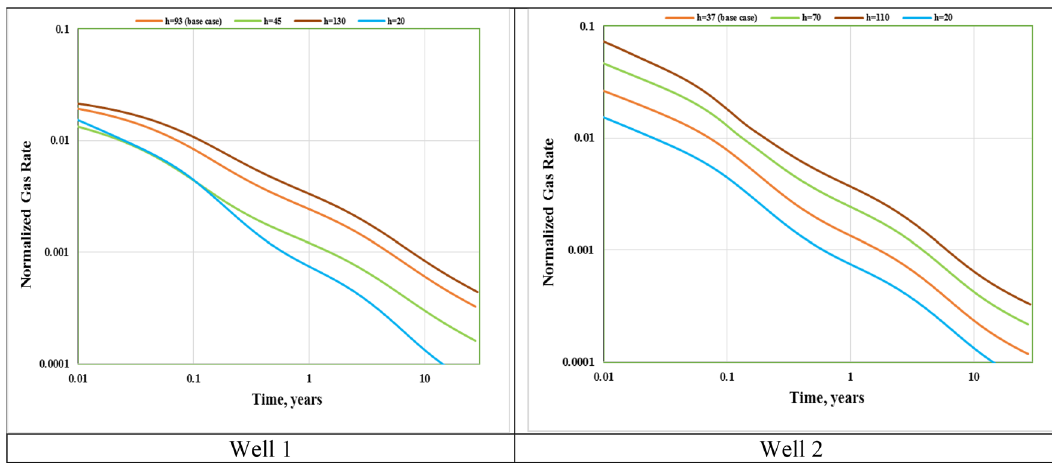
Fig. 13 Fracture height